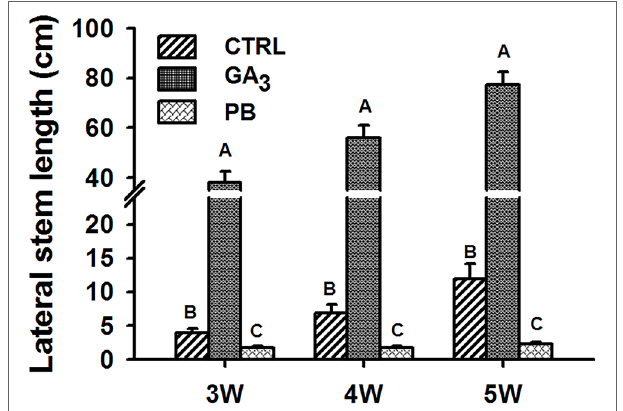
FiGURe 1 | Effect of GA 3 application on sweetpotato “ Georgia Jet ” stem growth. Lateral stem length was recorded at three, four, and five weeks (3W, 4W, and 5W, respectively) after planting. Bars represent mean of 16 independent biological replicates (plants) ± SE. Significance analysis was performed by using student’s t-test ( P ≤ 0.05) , where unlike letters represent significant differences between treatments within a sampling group. CTRL, Control (treated with water); GA 3 , application of 50 ppm gibberellic acid 3 for two weeks; PB, application of 5 ppm paclobutrazol for two